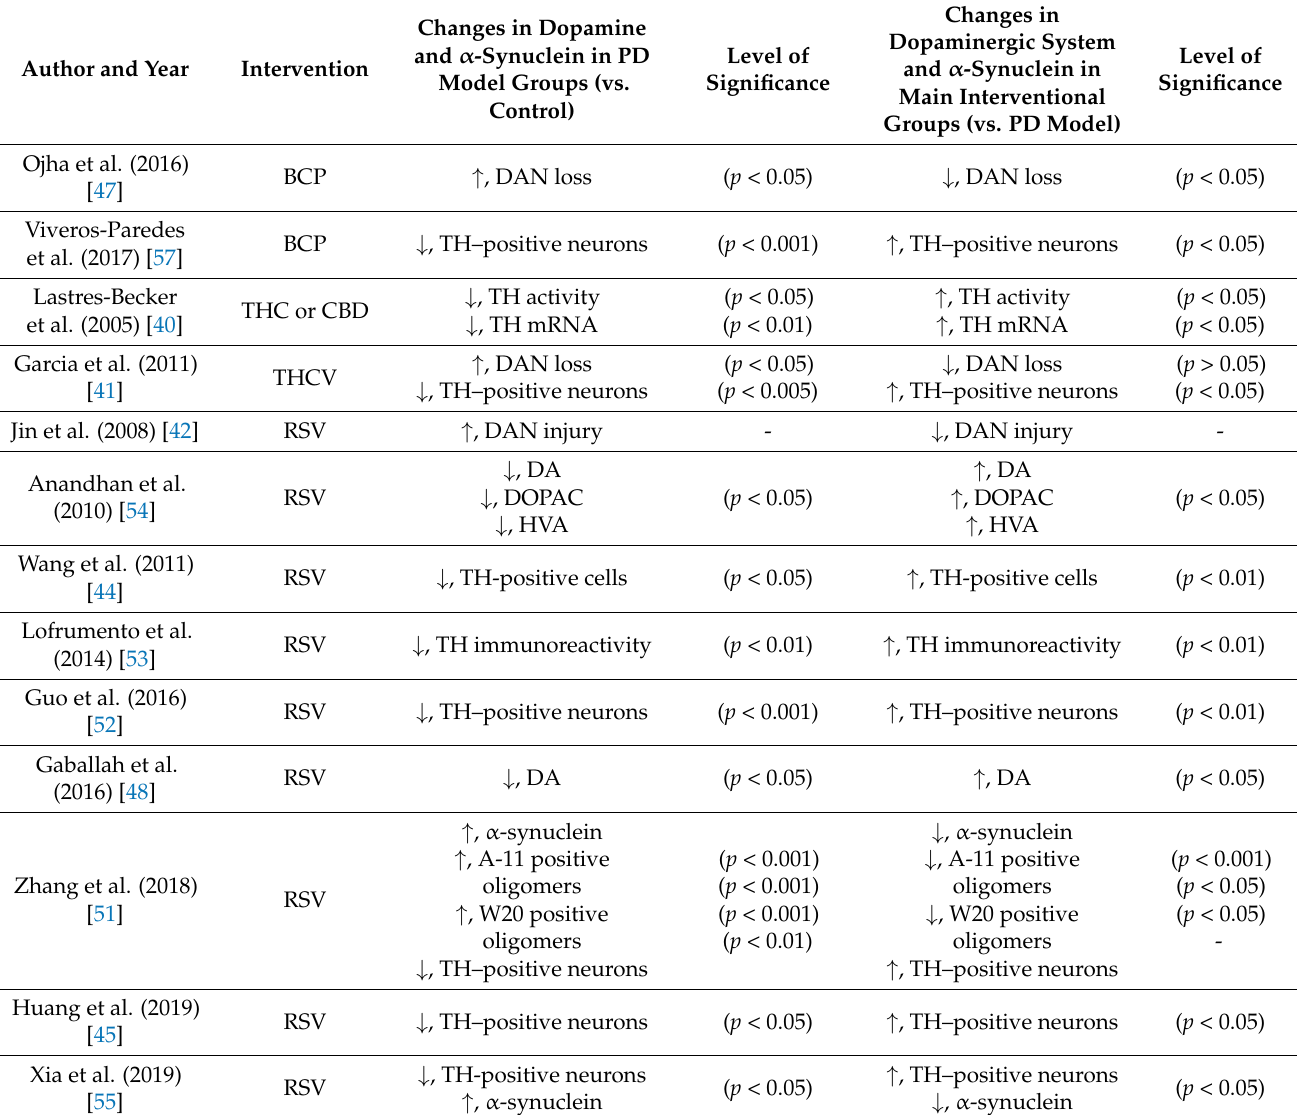
Table 4. Summary of biochemical and immunohistochemical analyses in PD model groups and